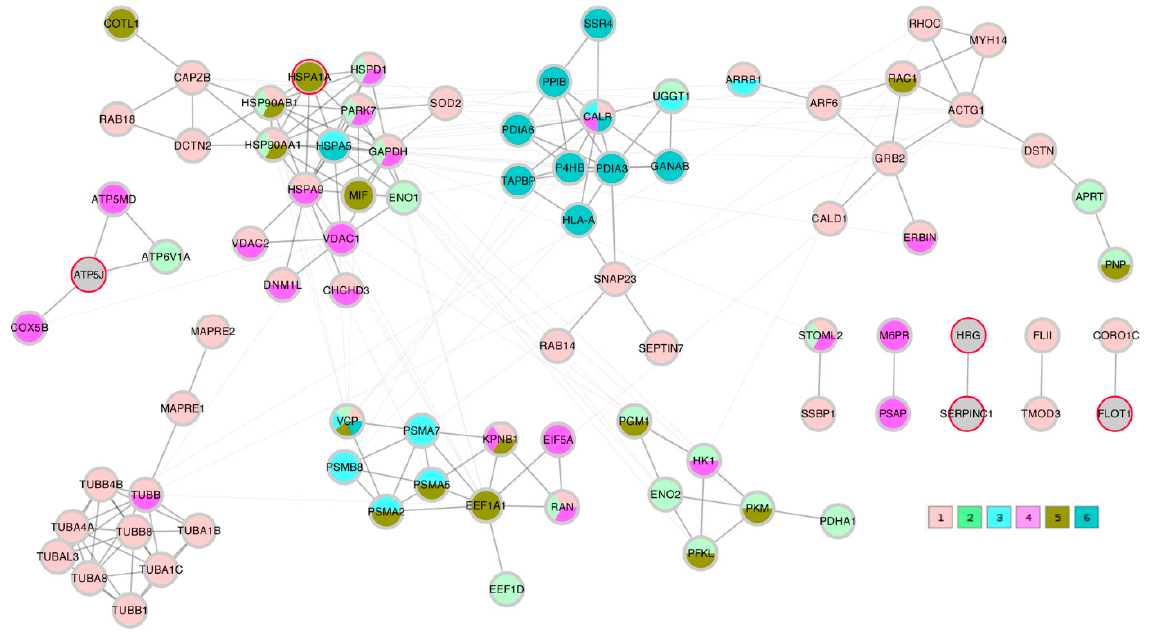
Figure 6. STRING protein-protein interaction network composed of proteins that were significantly correlating with the PTS metrics TK and RMS (PTS_TK/RMS) and the Lasso proteins. Edges represent a STRING combined score ≥ 0.7; they are drawn thick within community clusters, and thin across community clusters. Lasso proteins are marked with a red border (gray otherwise). Node colors at the bottom right refer to GO terms given in Table 4, with 1–3 standing for biological process and 4–6 cellular component.